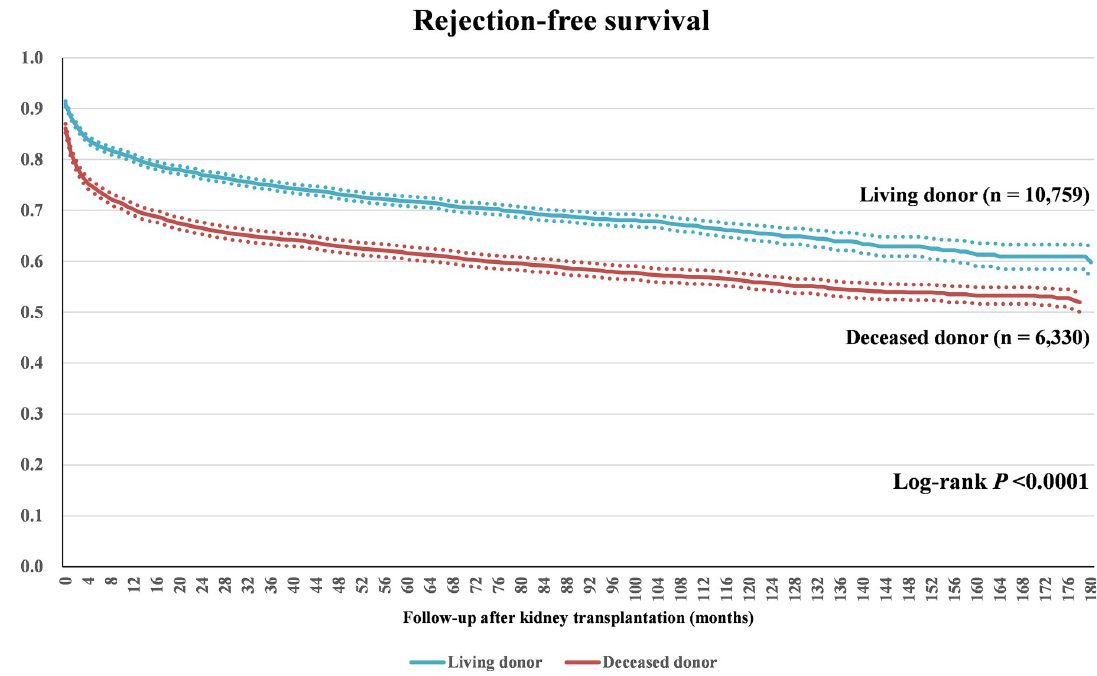
Fig 2. Rejection-free survival after kidney transplant. Dashed lines demonstrate 95% confidence intervals of the rejection-free survival rate.